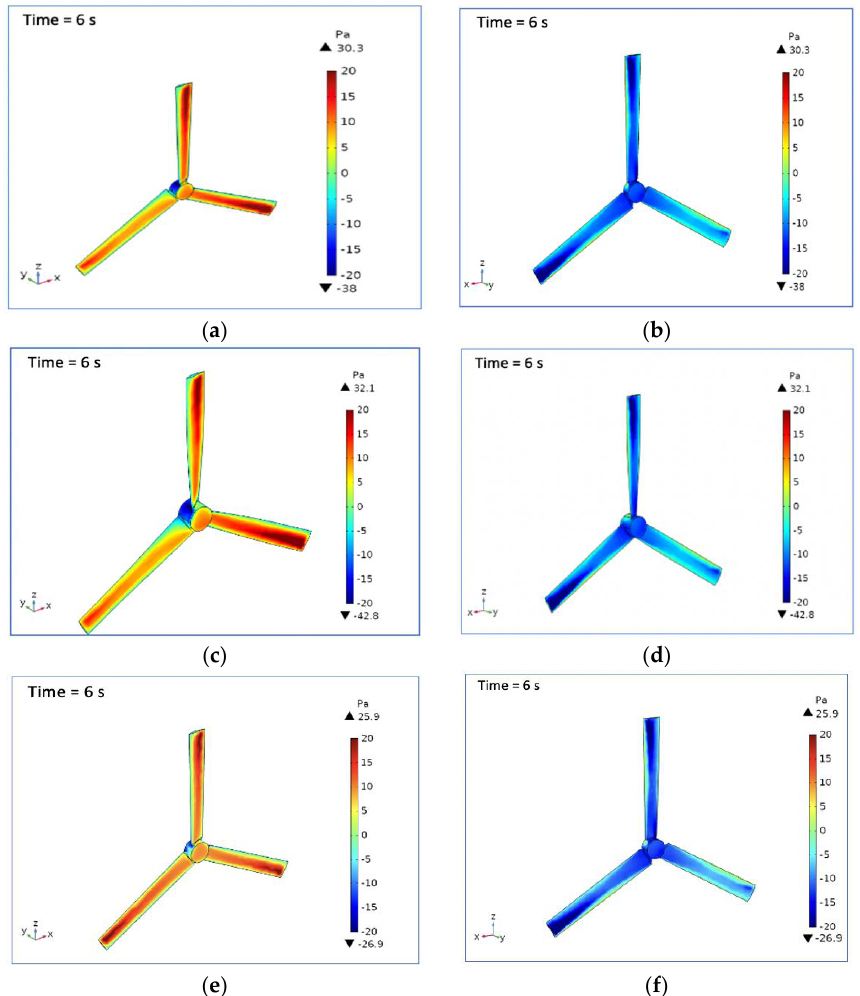
Figure 16. Negative suction pressure and positive pressure distributions for ( a , b ) Fit D, ( c , d ) Fit E, and ( e , f ) Fit F.